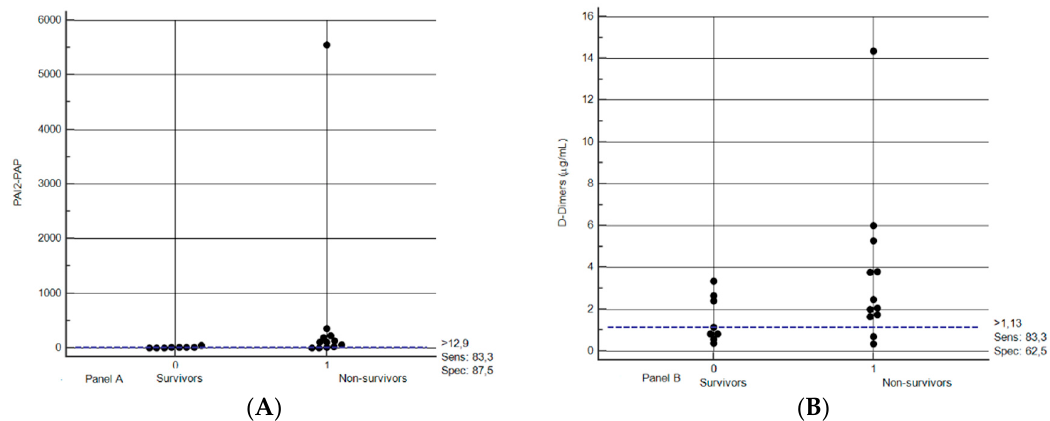
Figure 2. Dot plot distribution of PAI-2/PAP ratio ( panel A ) and D-dimers ( panel B ) in survivors and nonsurvivors. PAI2: plasminogen activator inhibitor 2; PAP: plasmin–antiplasmin complex. Data in the text.